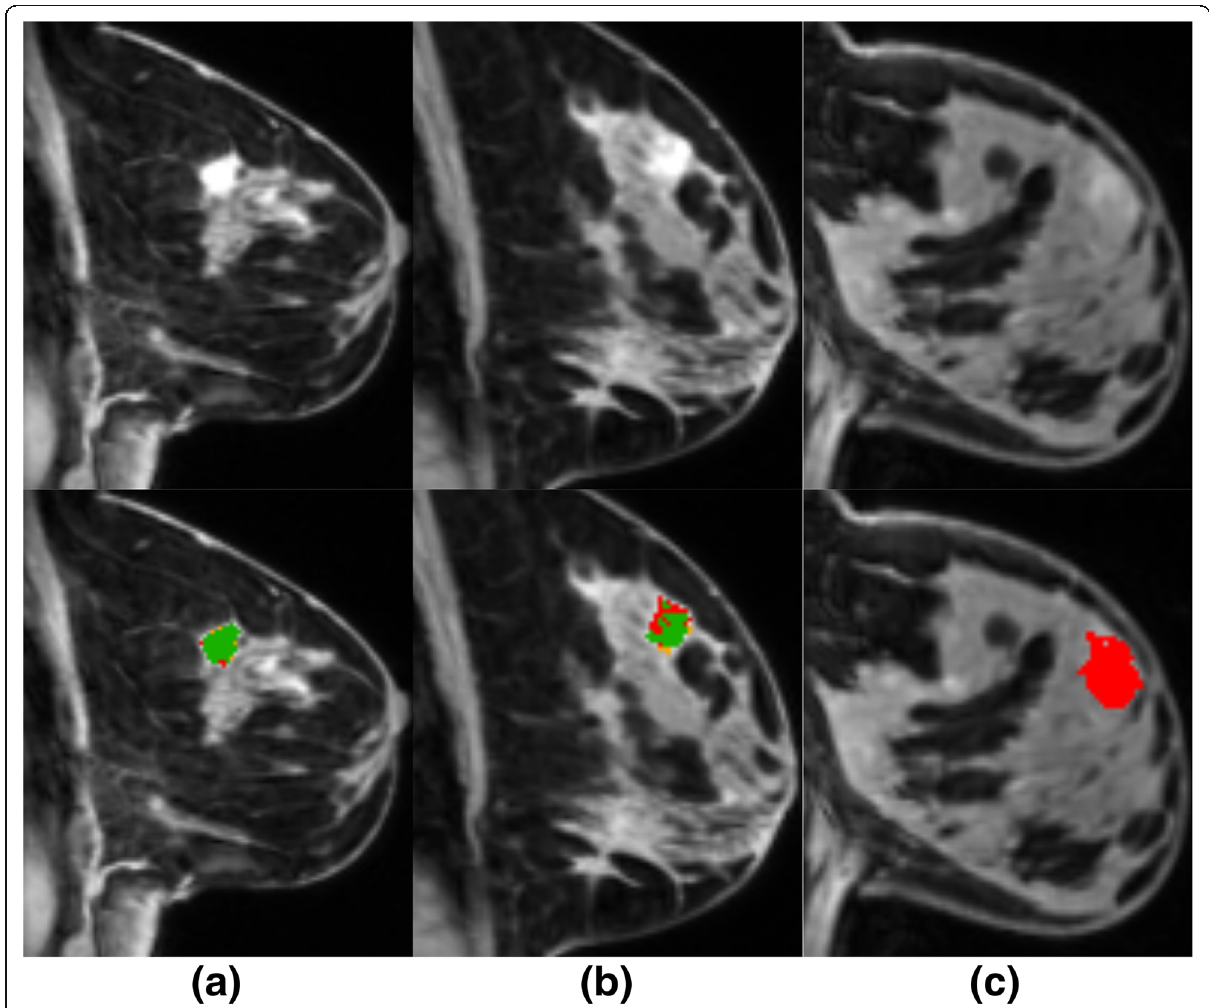
Fig. 4 Segmentation results for the ( a ) best, ( b ) median, and ( c ) worst case according to the DSC score. The green colour indicates true-positive voxels, the yellow colour false-positive voxels, and the red colour false-negative voxels. Top row shows I